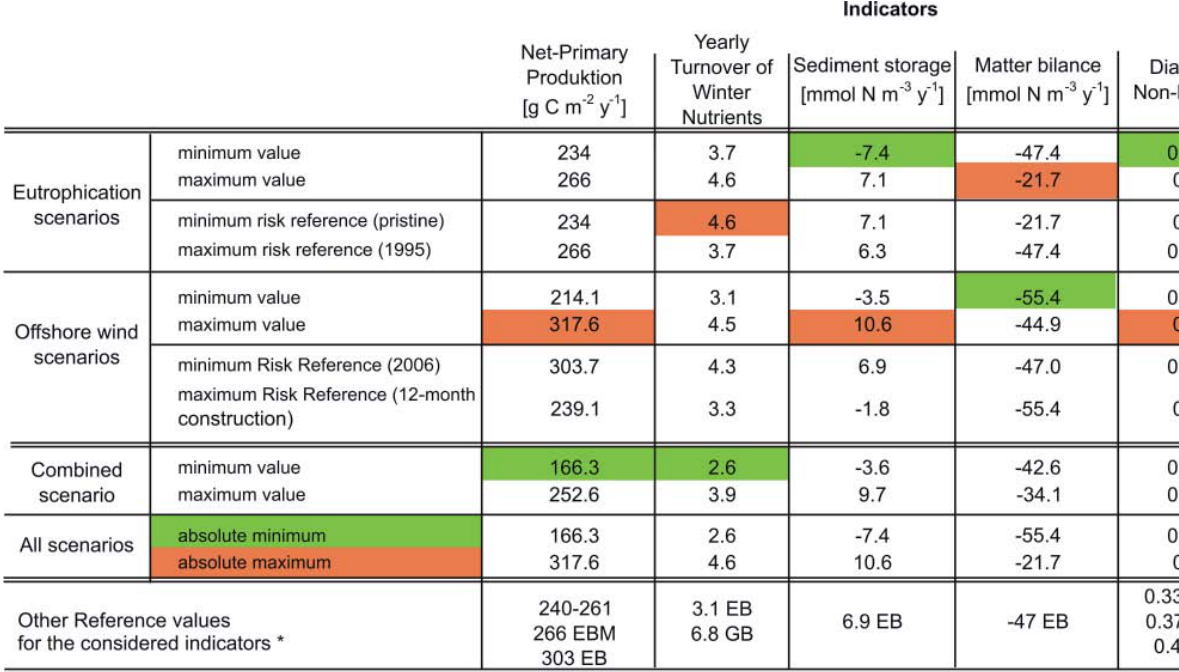
Table 2. Overview of minimum and maximum indicator values throughout the scenarios. The minimum and maximum integrity indicator values for each case-study can be compared with (1) the selected references for minimum and maximum disturbance (minimum and maximum risk) as well as (2) available literature data or ERSEM standard modelling runs. Please note that the minimum and maximum values listed in the table are the minimum and maximum found among all scenarios for a single case study (i.e. eutrophication, offshore wind farm construction or the combined scenario) and the values repor- ted in a row may not correspond to a single scenario of the case